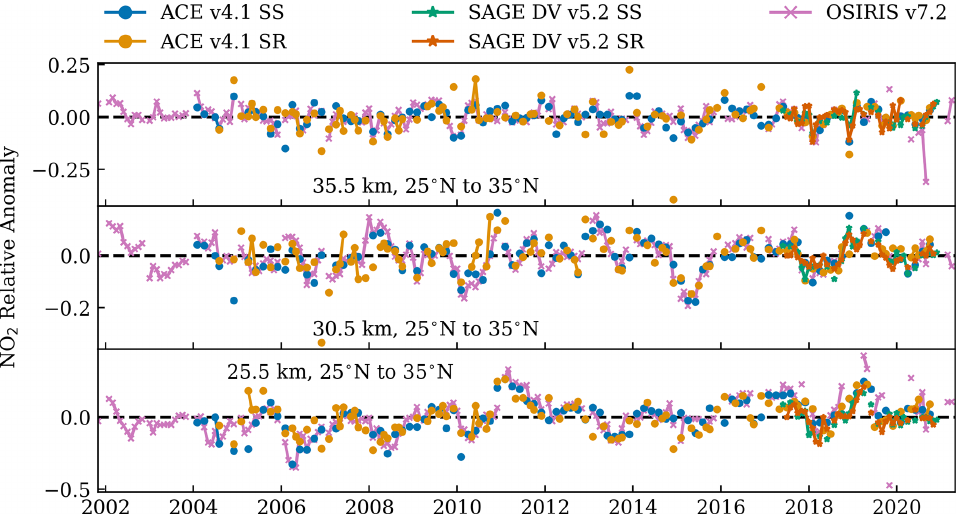
Figure A2. Anomaly time series comparing OSIRIS v7.2 to ACE v4.1 and SAGE III/ISS v5.2 DV for three altitudes at Northern Hemisphere